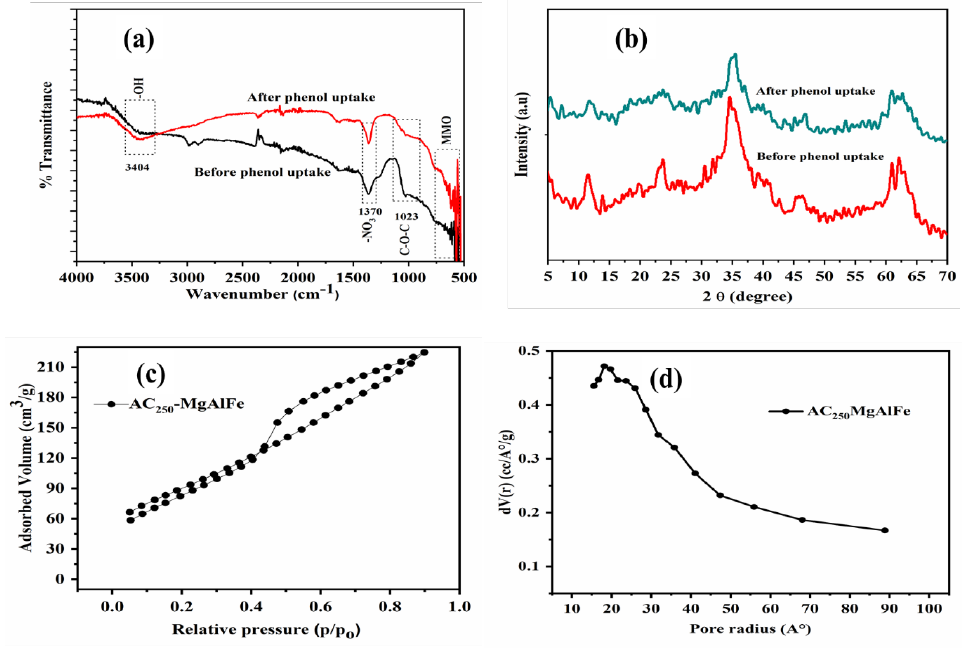
Figure 1. SBAC-MgAlFe characterization results: ( a ) XRD, ( b ) FTIR, ( c ) N 2 adsorption–desorption isotherms, ( d ) pore size distribution.